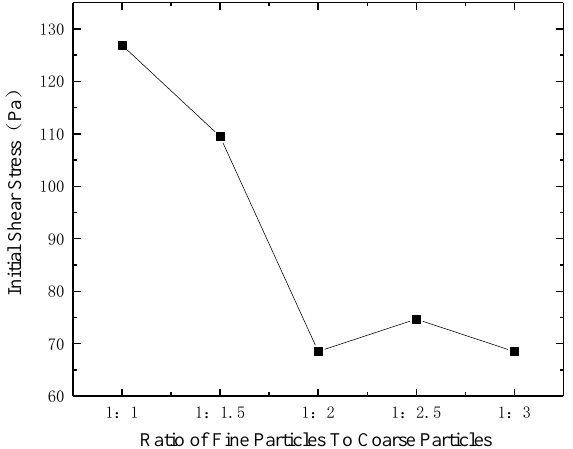
Figure 12. Relation between initial shear stress and different ratios of fine particles to coarse particles.